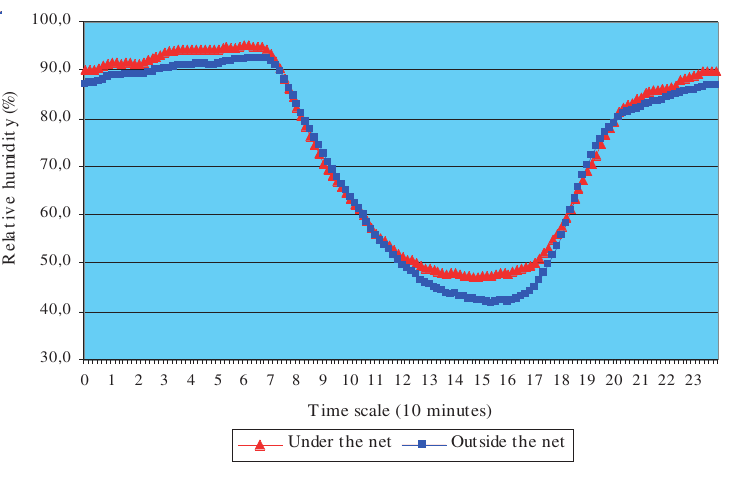
Figure 4 . The mean daily course of the relative air humidity measured under the hail net and outside of it /Pallag 2011 June 1 – September 30./